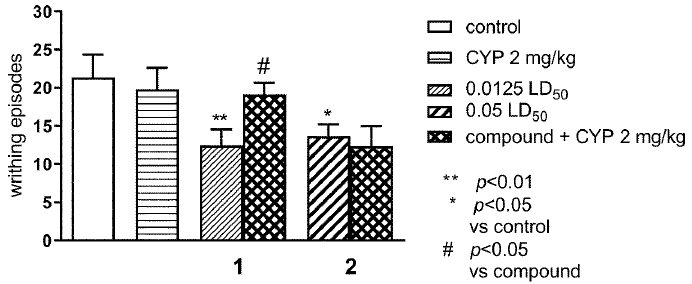
Figure 2. Effect of pre-treatment with CYP on the antinociceptive effect of new compounds 1 (0.0125 LD50) and 2 (0.05 LD50) in the ‘writhing’ test in mice. The tested compounds 1 and 2 were injected i.p. 60 min before the test and CYP, 2 mg/kg, s.c. 25 min before the test. Data are expressed as mean ± SEM values. Groups of 10–12 animals were tested. ** p < 0.01; * p < 0.05 vs. control vehicle-treated group, # p < 0.05 vs. respective compound (Bonferroni’s test).